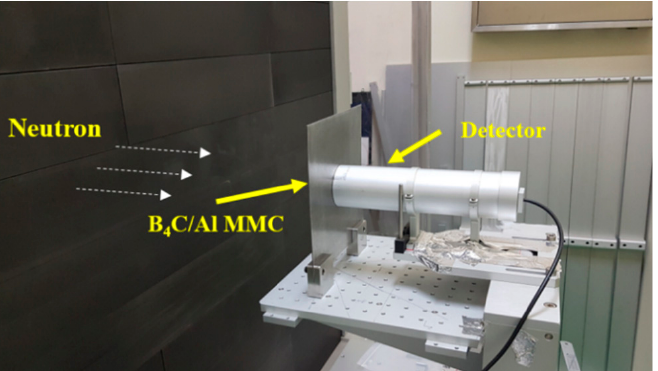
Figure 8. Photograph of neutron attenuation test facility for B 4 C/Al composites at Korea Research Institute of Standards and Science (KRISS).